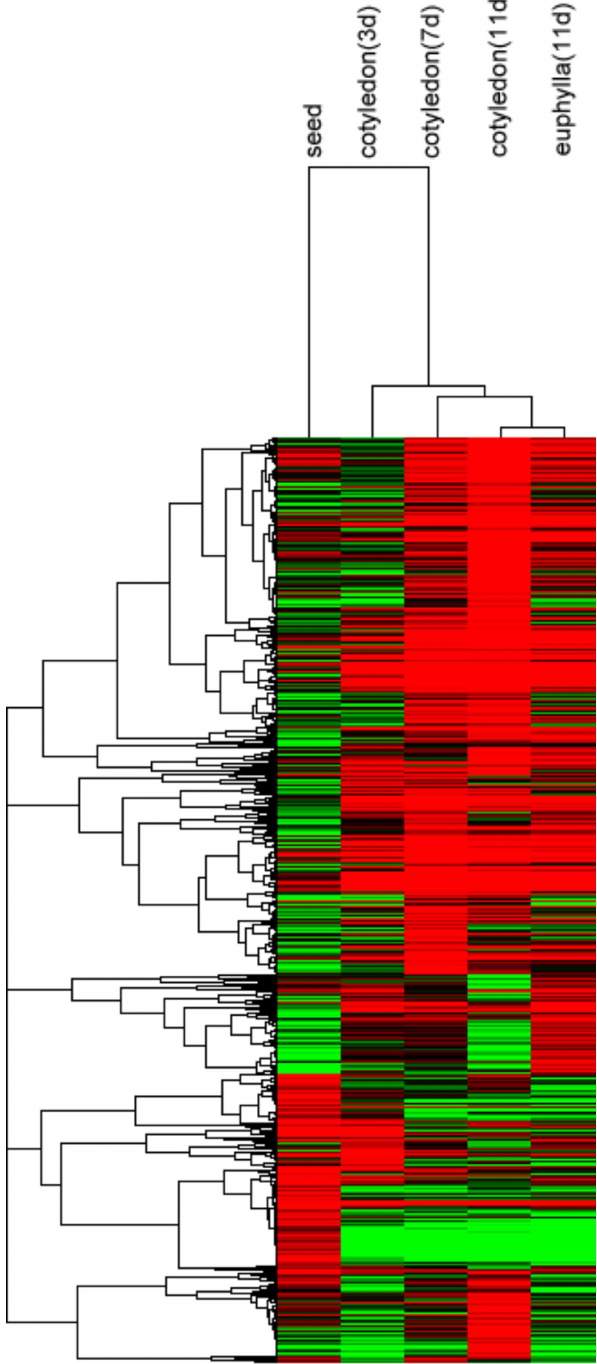
Figure 4. Cluster of differentially expressed genes during broccoli seed germination and sprout development. Expression changes and cluster analysis of 2675 genes that were differentially expressed between any two of the five samples. Each row represents a differentially expressed gene, while each column represents a sample. Changes in expression levels are shown in color scales with saturation at . 2.0-fold changes. Green and red color gradients indicate a decrease and increase in transcript abundance, respectively.